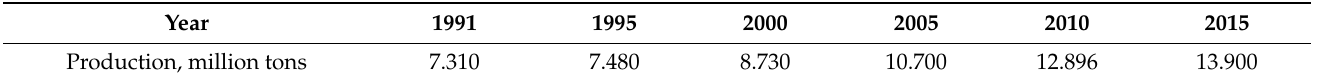
Table 2. The volume of global zinc production in 1991–2015, worked based on [18–26].